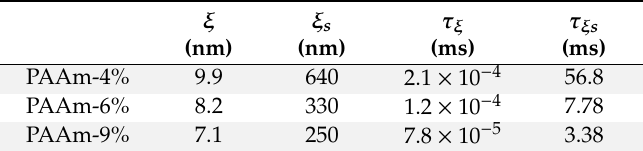
Figure 5. Influence of microstructural gradients on hydrogel friction. ( a ) Schematics representing the di ff erent microstructure of hydrogel surfaces when molded against a hydrophilic and a hydrophobic surface, respectively. The former yields a uniform (gradeless) polymer network, whereas the latter leads to a brush-like surface region that exhibits a lower polymer volume fraction and a reduced crosslink density compared to the bulk hydrogel [44]. Reprinted from Gombert, Y. et al. Structuring Hydrogel Surfaces for Tribology. Advanced Materials Interfaces, 2019 , 6 , 1901320. Copyright (2019) via Creative Commons license: https: // creativecommons.org / licenses / by-nc / 4.0 / . ( b ) Change of the friction coe ffi cient for di ff erent hydrogel-hydrogel contacts under a pressure of 6 kPa. Lower friction coe ffi cients with weak velocity dependence are obtained for brush–brush configurations and for migrating brush–crosslinked network contacts. Higher friction coe ffi cients that increase with sliding velocity are measured for contacts between crosslinked networks and for static brush–crosslinked network contacts. The measurements in ( b ) were carried out using a microtribometer in a flat pin-on-disc configuration in reciprocating motion (configuration 4 in Figure 2e) [28]. Reprinted from Simiˇc, R. et al. Importance of Hydration and Surface Structure for Friction of Acrylamide Hydrogels. Tribology Letters, 2020 , 68 , 1–12. Table 3. Comparison of the relaxation times ( τ A ) estimated using the bulk mesh size ξ and the length of the brushy region at the surface of the hydrogel ξ s for the polyacrylamide hydrogels investigated in Ref. [23]. The hydrogels were prepared with 4, 6 and 9 wt % monomer and 0.1, 0.3 and 0.45 wt % crosslinker concentrations, and are labeled as PAAm-4%, PAAm-6% and PAAm-9%, respectively. Calculations performed at a temperature of 298 K and for a solvent viscosity of 0.89 mPa ·